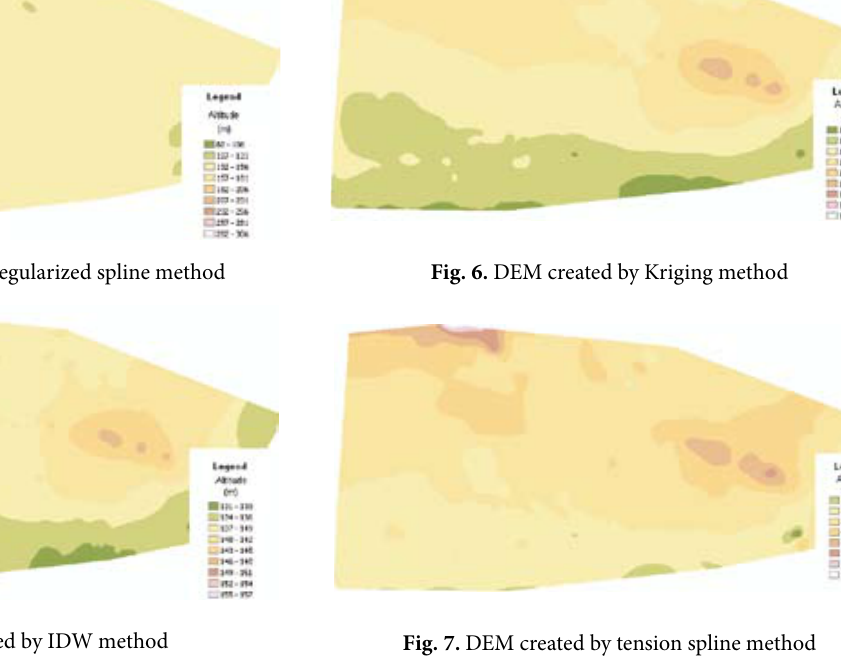
Fig. 7. DEM created by tension spline